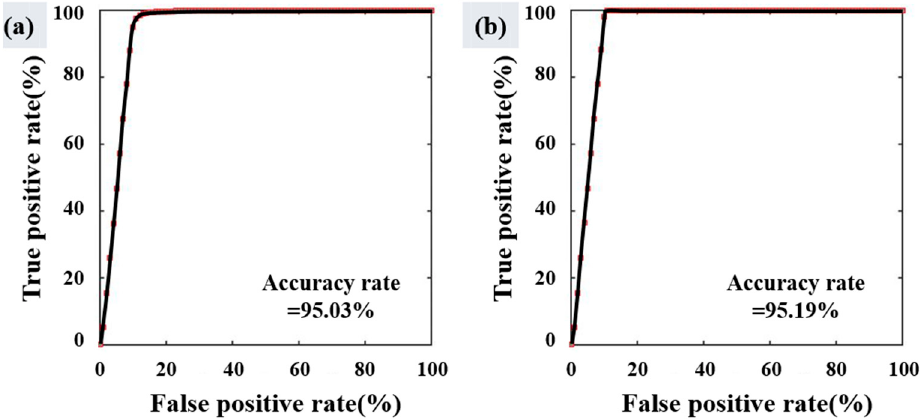
Figure 11. Histogram of sites B and C. ( a ) Histogram of results of Process 1 and Process 2 at oil-free surface; ( b ) Histogram of results of Process 1 and Process 2 at oil-covered surface.